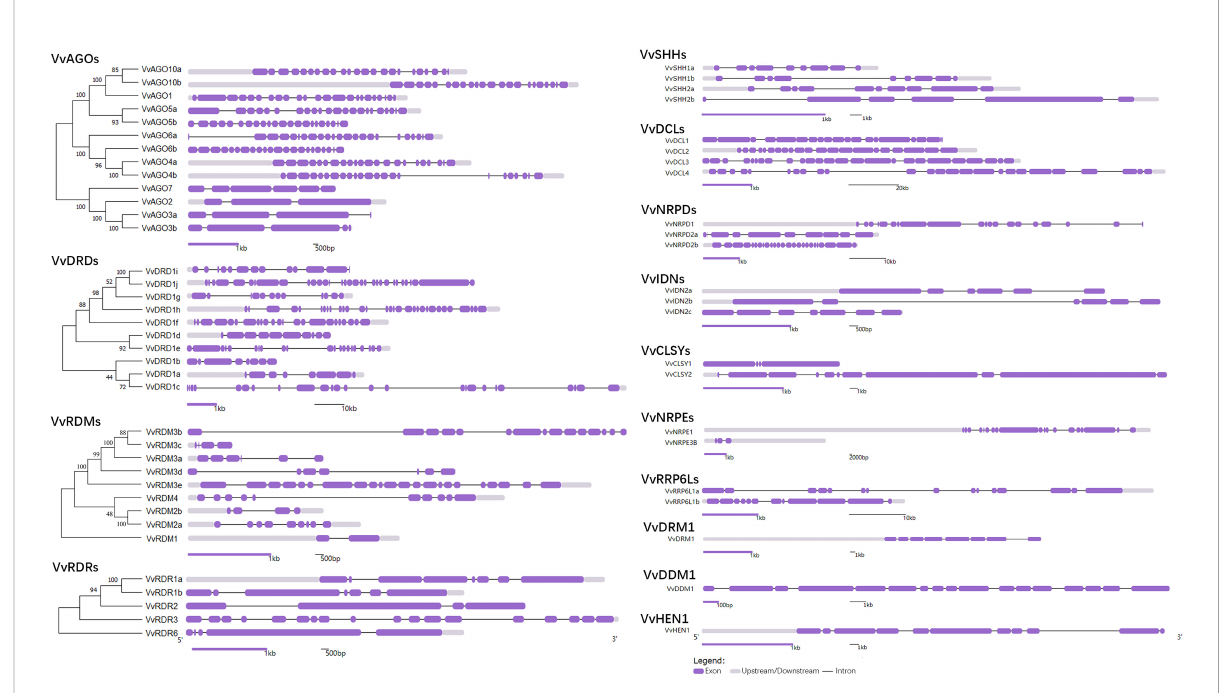
FIGURE 2 Phylogenetic tree and exon-intron distribution of VvRdDM genes. Purple boxes and black lines denote exons and intron,